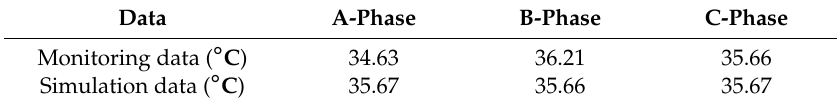
Table 3. The measured temperature data and the simulation temperature